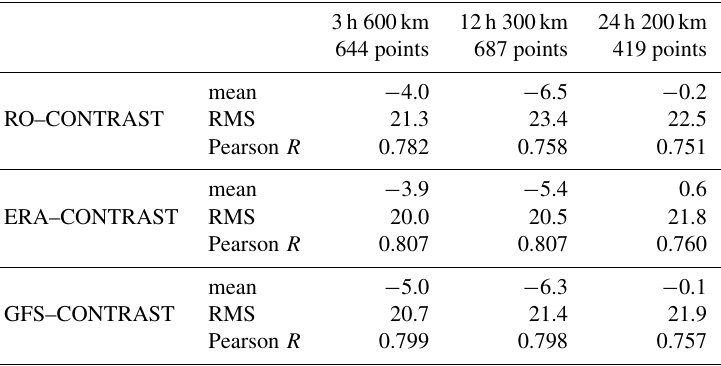
Figure 5. MTSAT-2 satellite images of brightness temperatures for 20 February 2014 around 00:00UT. Left: MTSAT-2 IR (10.3 to 11.3µm); right: MTSAT-2 IR water vapor (6.5 to 7µm). Table 2. Mean, RMS, and Pearson R coefficients for differences in relative humidity of RO–CONTRAST, ERA–CONTRAST, and GFS– CONTRAST for three different collocation